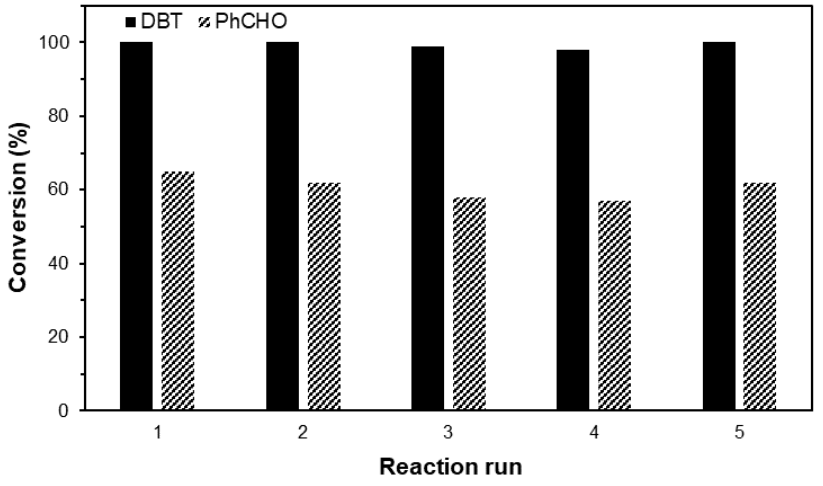
Figure 4. Catalyst reuse for co-oxidation of DBT (0.50 mmol) and PhCHO (3.7 mmol) at 100 °C, HPA-1 (0.10 g, 0.048 mmol), 10 mL dodecane, 1300 rpm stirring speed, 20 mL min − 1 air flow rate, 2 h reaction time.